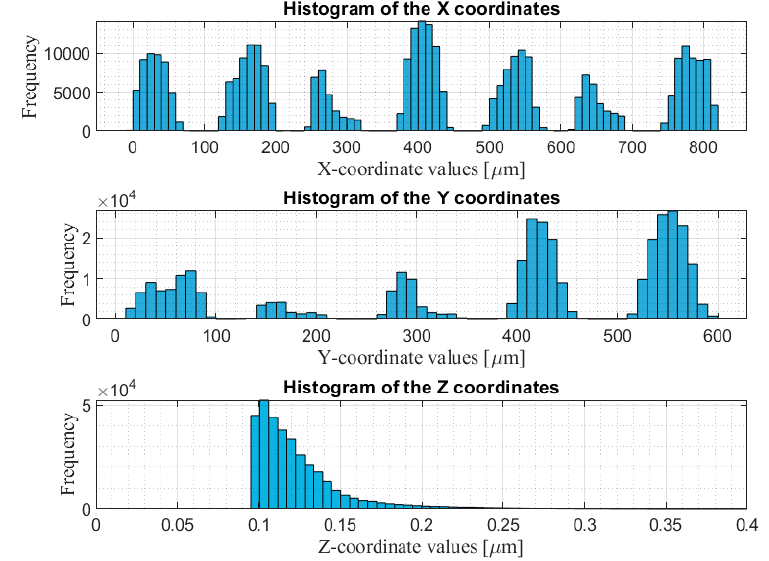
Figure 4. Histograms of the X, Y, and Z coordinates of the aligned